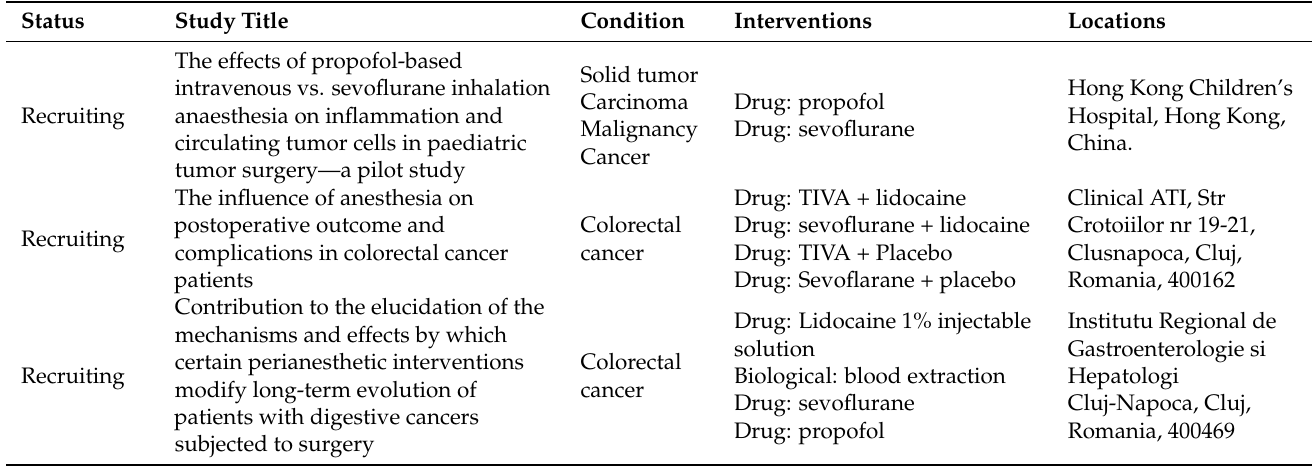
Figure 4. Schematic illustration of volatile anesthetics in the regulation of cancer progression. The right half represents the anti-cancer effects of sevoflurane in the treatment of various cancers. The left half represents the treatment of sevoflurane induces proliferation, migration, invasion, and EMT in certain cancers. The brown color represents the signaling pathways elicited by HIF-1 α . This figure is made by an online tool at BioRender.com (accessed on 15 June 2022). Since NK cells are known to involve in cancer recurrence/metastasis in the pre-oper- Table 2. Clinical application of sevoflurane in the treatment of